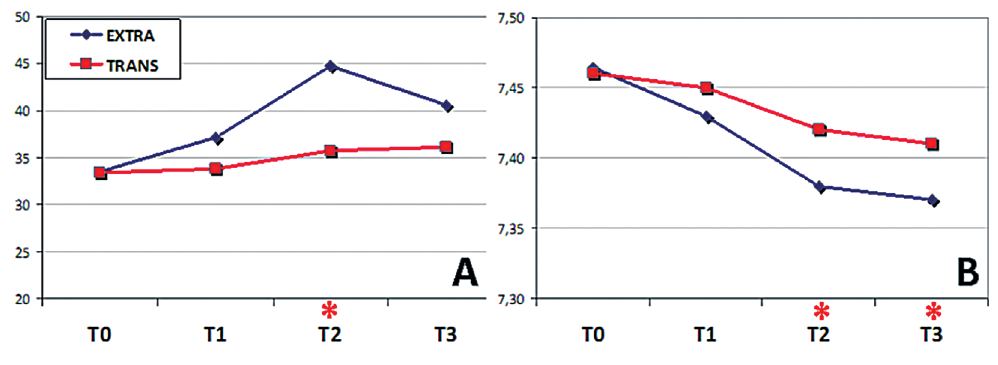
*TP vs EP groups,